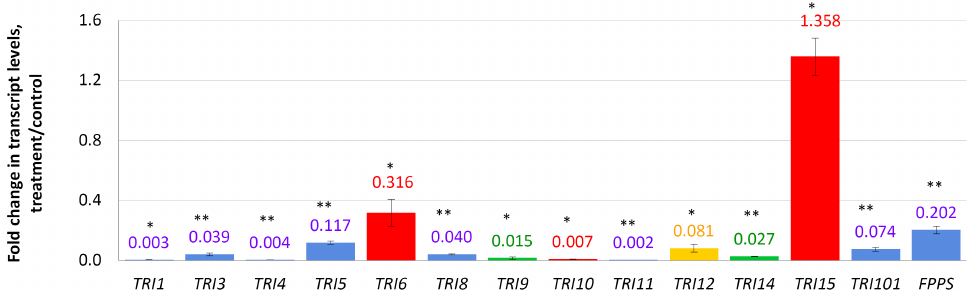
Figure 2. Effect of compactin on the relative expression of genes responsible for DON biosynthesis and regulation. The expression level for the untreated control was considered as 1.0. EL above or below 1.0 means up- or down-regulation, respectively. Blue bars indicate genes encoding biosynthetic enzymes; red bars indicate genes encoding regulation factors; yellow bar indicates the TRI12 gene encoding transport protein (TRI efflux pump); green bars indicate genes with unknown functions. Each bar is shown as M ± SD; * p < 0.05; ** p < 0.01.